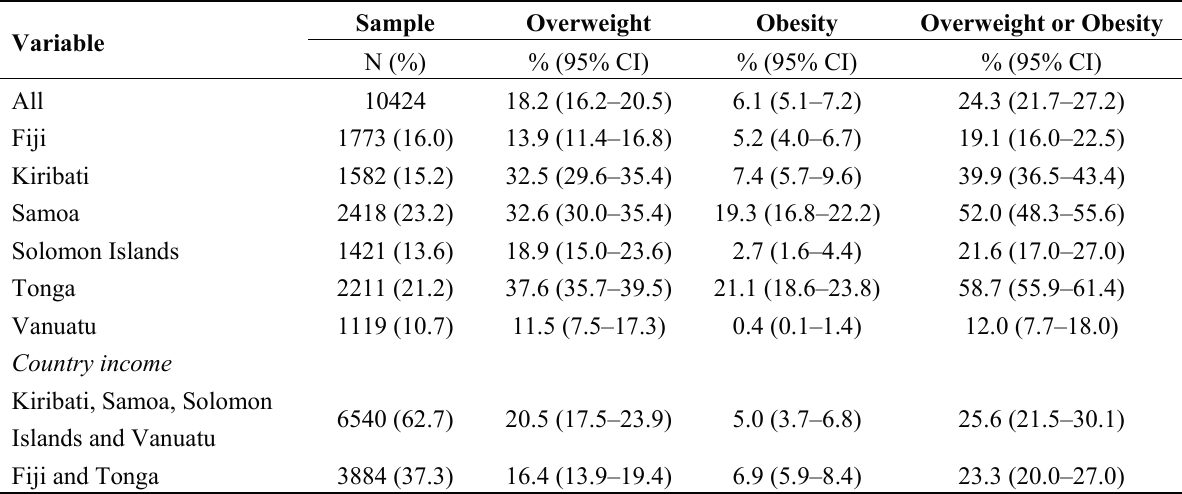
Table 1. Descriptive data of school-going adolescents aged predominantly 13–16 years (N =